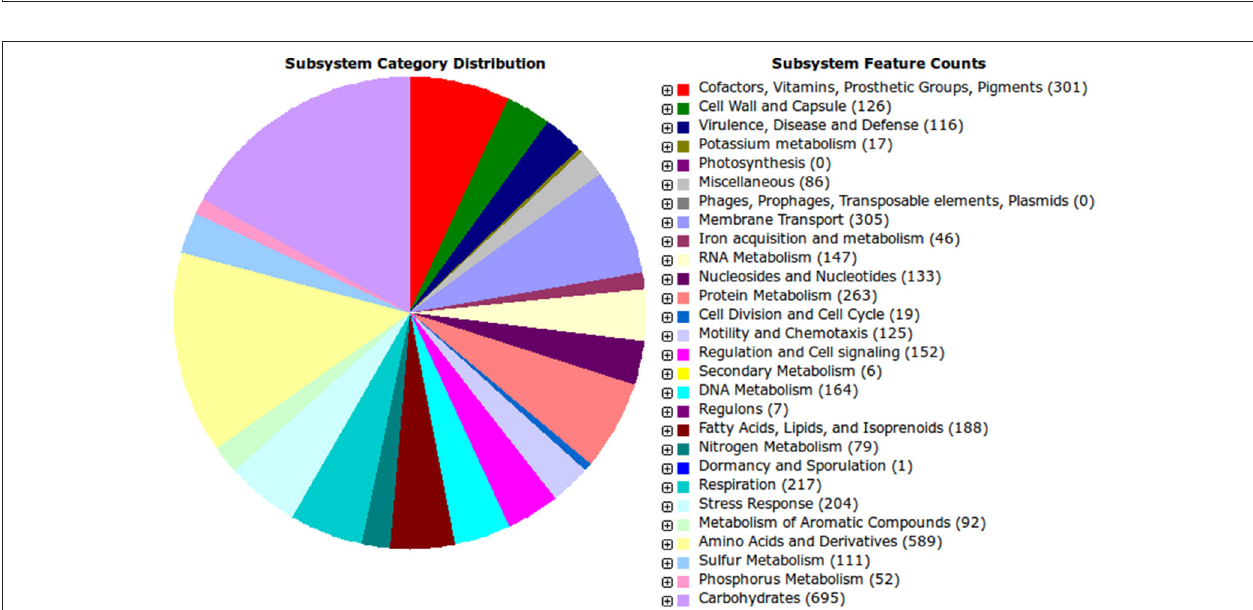
FIGURE 3 | Gene category classification results. The annotation data obtained from the RAST procedure were used to assemble the image.